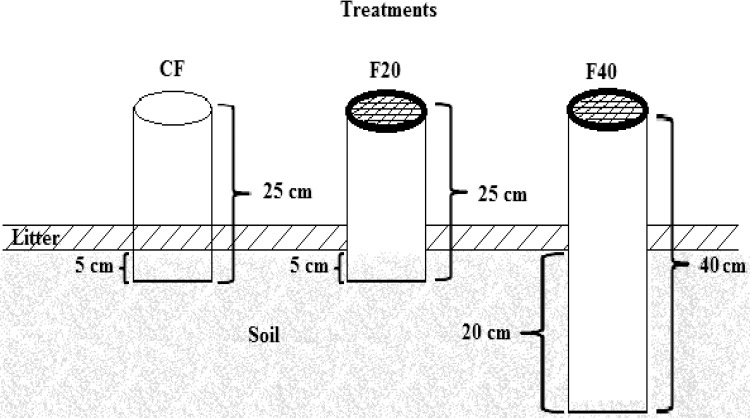
Treatments for CO2 measurements.(CF) Controls flux, (F20) Flux of 20 cm, (F40) Flux of 40 cm.